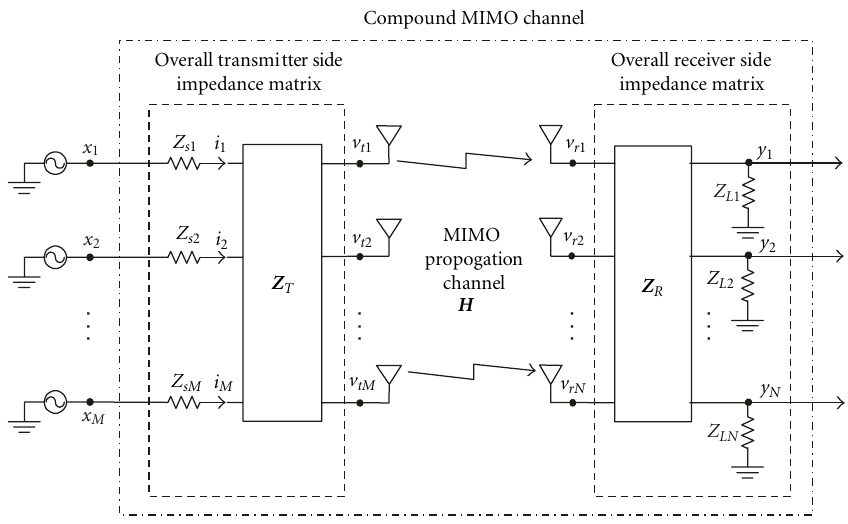
Figure 2: Network model for a ( M , N ) compact MIMO system.